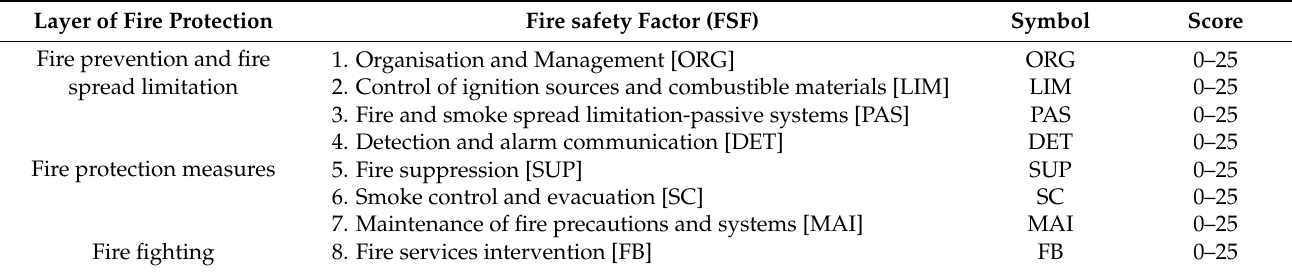
Table 2. Fire safety factors in fire strategy.